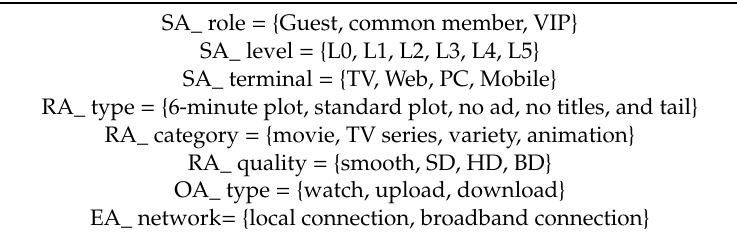
Table 1. Set of attribute values for each attribute.